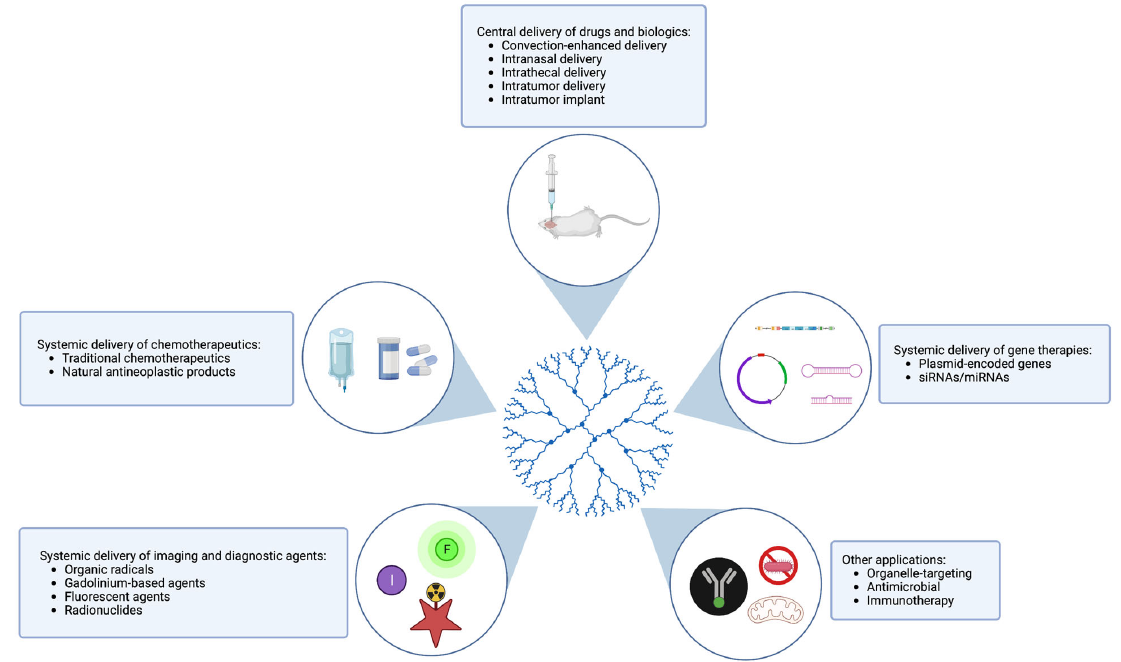
Figure 4. Potential applications of dendrimers in the treatment and diagnosis of glioma. Dendrimers and dendrimer conjugates with functional and targeting moieties attached have been used to deliver chemotherapeutic drugs directly to the tumor site when delivered systemically or intratumorally. Dendrimer conjugates can also be used to deliver biologics, including DNA ‐ and RNA ‐ based agents, to tumor sites for the purposes of gene therapy. In addition, dendrimers can be used for imaging and diagnostic purposes, including as agents for MRI/PET/SPECT modalities. Other novel applica ‐ tions of dendrimers in glioma include organelle ‐ specific targeting, antimicrobial activity, and im ‐ munotherapy.